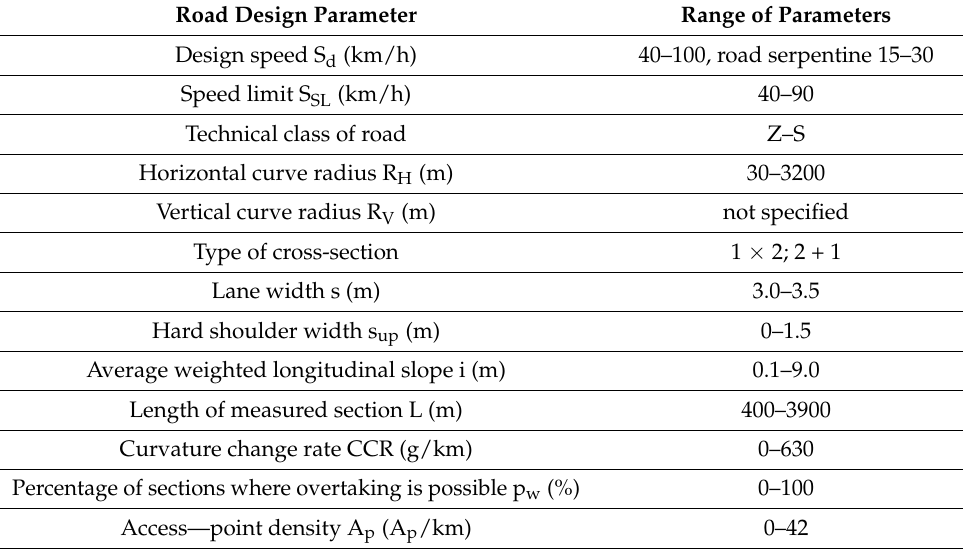
Table 3. Technical parameters of two-lane highways covered by the RID-I − 50